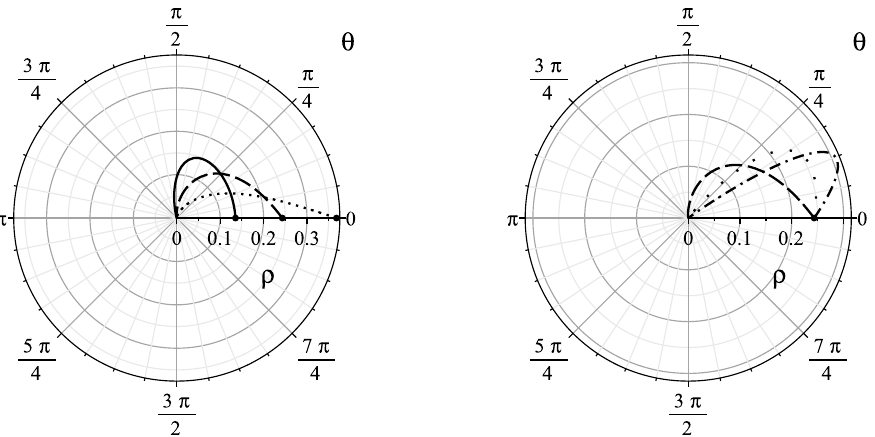
(cid:0) (cid:1) (cid:26) ( t ) ; (cid:18) ( t ) for the same values of the constants as in (cid:12)gure